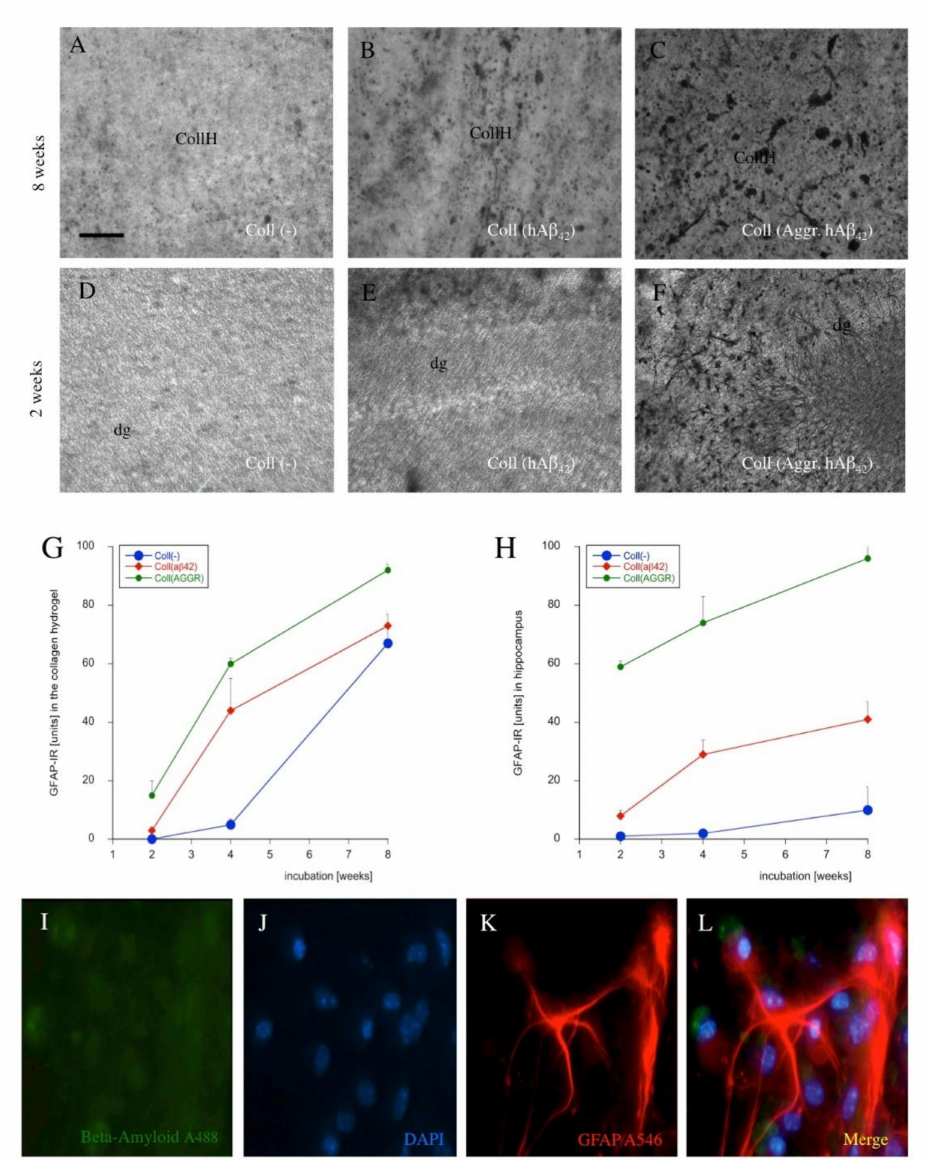
Figure 9. Astroglial responses stained for glial fibrillary acid protein (GFAP). Co-slices were loaded with an empty collagen hydrogel (Coll(-)), A , D ), human beta-amyloid(42) (Coll(hA β 42 ); B , E ) or aggregated beta-amyloid (Coll(Aggr.hA β 42 ); C , F ) and analyzed in the area where the hydrogel was placed (area 1) after eight weeks ( A – C ) or in the hippocampal area (area 2) after two weeks ( D – F ). Quantification over time is given in ( G ) (in area 1) and ( H ) (hippocampal area 2). Values are given as mean ± SEM ( n = 3). Co-staining of beta-amyloid ( I , A488, green) and GFAP ( K , A546, red) with nuclear DAPI ( J , blue) showed that the beta-amyloid-like immunostaining did not co-localize with GFAP+ astrocytes ( L , merge). Scale bar in A = 90 µ m ( A – C , D – F ) and 40 µ m ( I – L